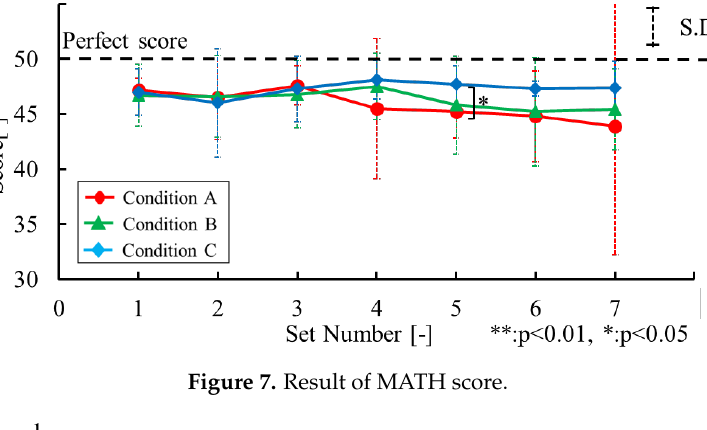
Figure 6. Drowsiness level reached when calculating MATH (analysis of facial expressions based on Zilberg’s method [20]).